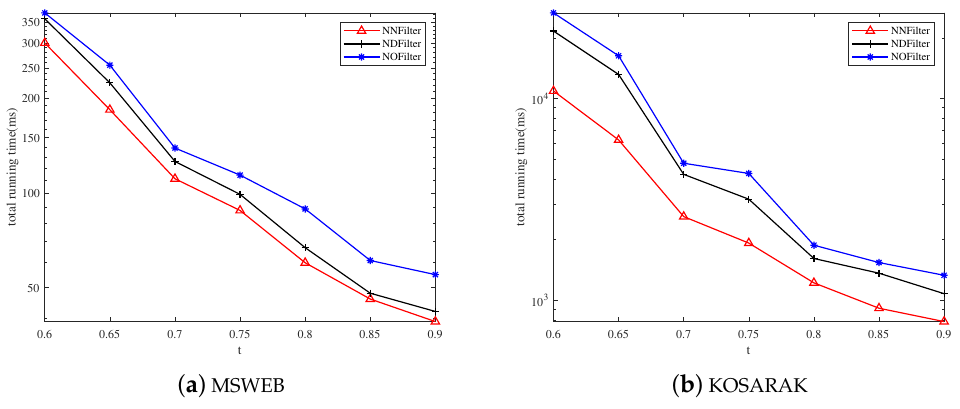
Figure 6. The results for different filtering